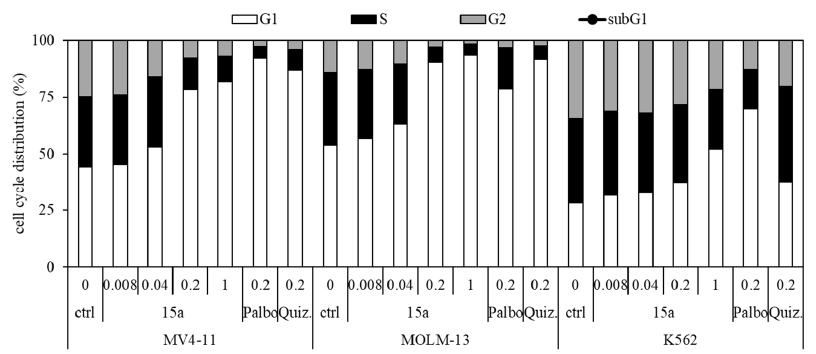
Figure 4. Cell cycle G1 phase population upon treatment of MV4-11 ( A ) and K562 ( B ) cells with a 200 nM concentration for 24 h. Data (in %) are expressed as differences between G1 populations in treated and control cells. PALBO, palbociclib; QUIZ, quizartinib.